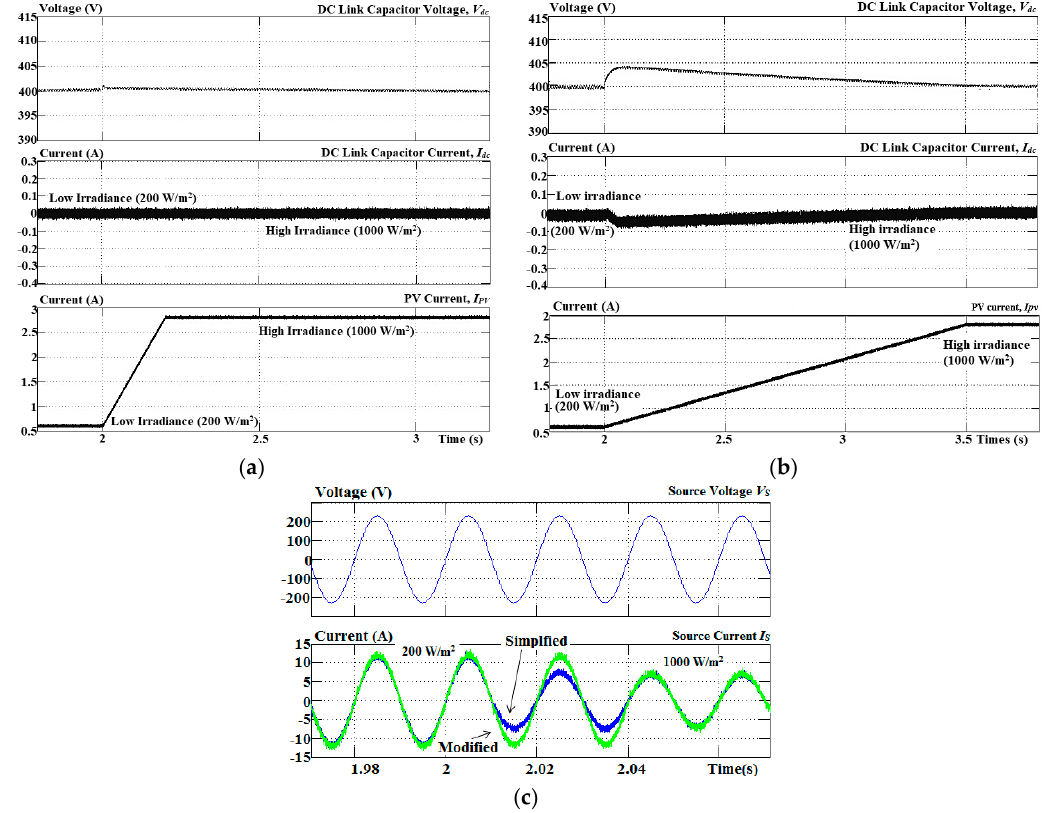
Figure 11. Simulation results of DC link capacitor voltage under low to high irradiance using ( a ) step size error cancellation and ( b ) direct control in self-charging algorithms; ( c ) performance of current harmonics extraction